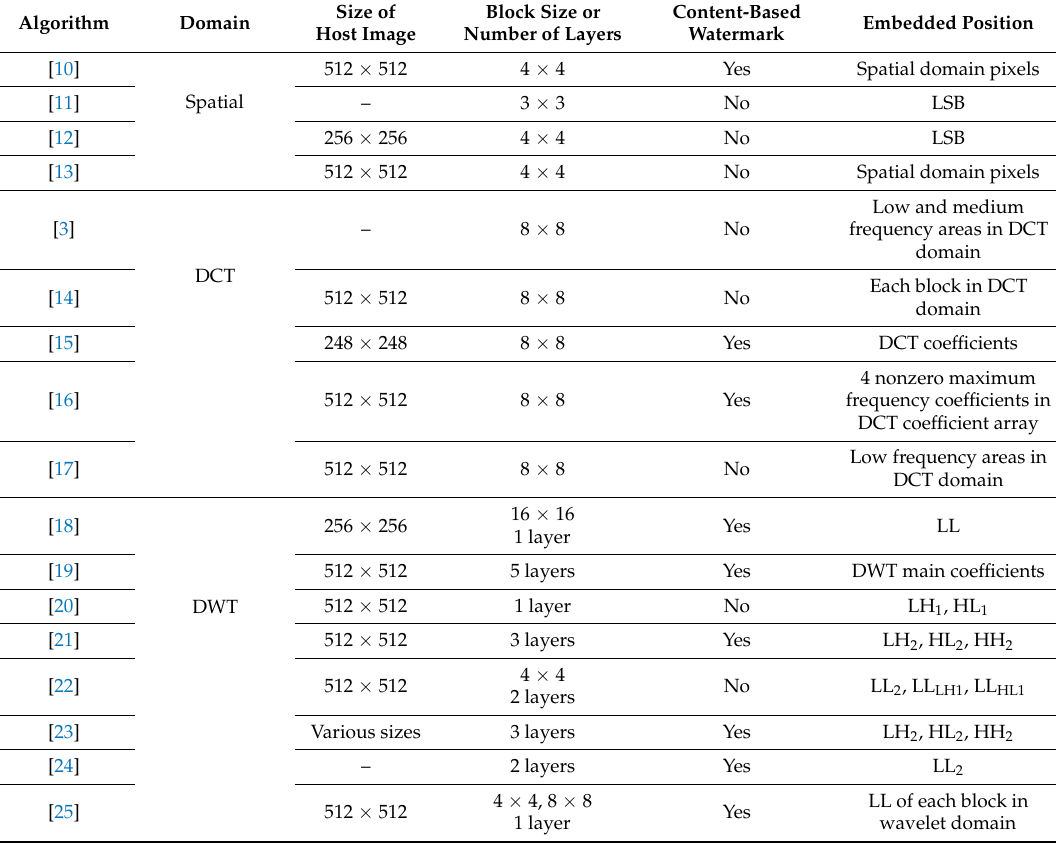
Table 1. Basic information of various unrecoverable algorithms.